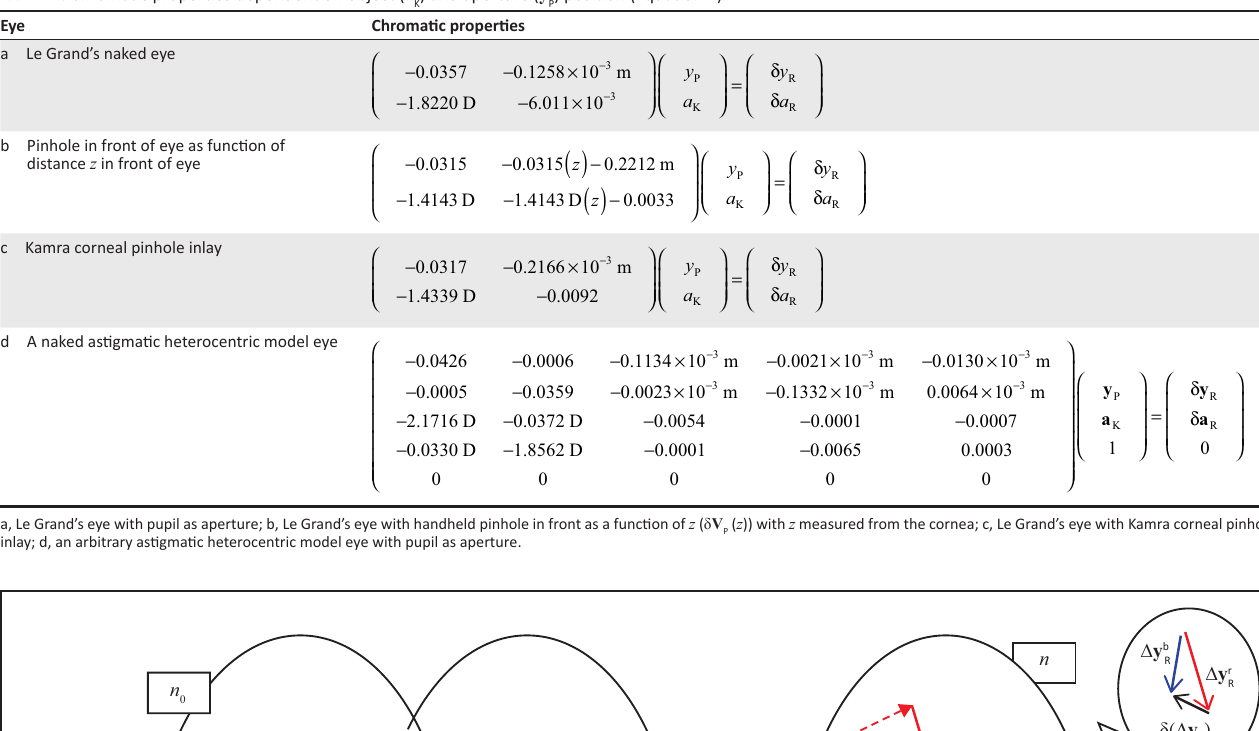
TABLE 2: Chromatic properties dependent on object ( a Eye Chromatic properties a Le Grand’s naked eye b Pinhole in front of eye as function of distance z in front of